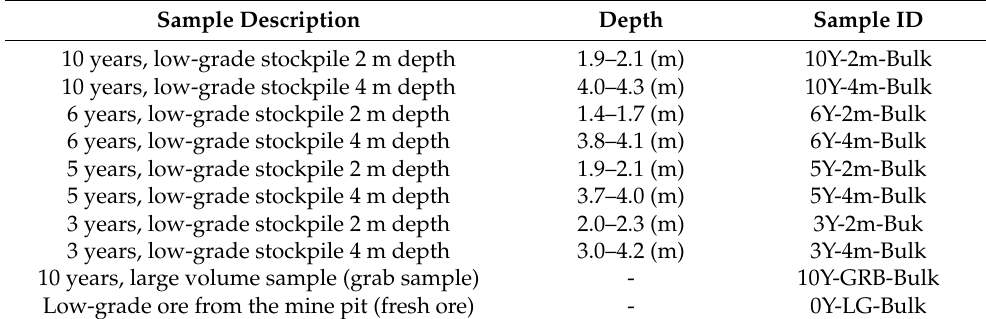
Table 1. List of samples, showing the period of stockpiling and the depth from which they were collected in the stockpile.